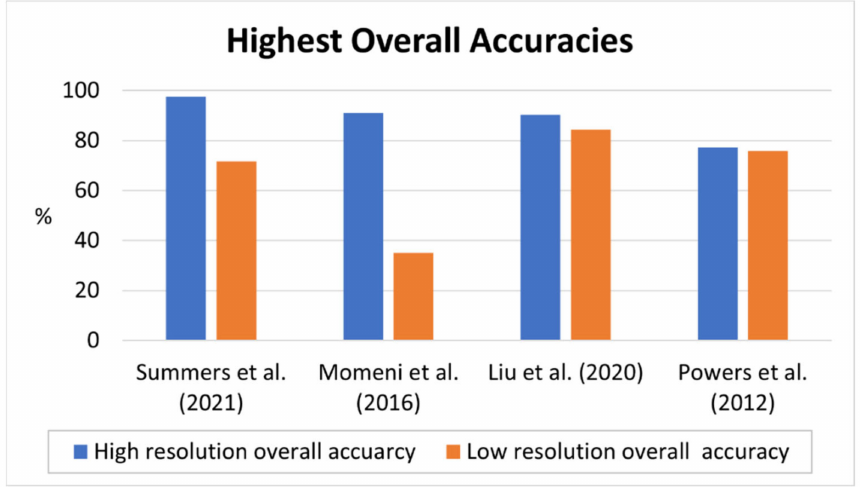
Figure 11. The highest overall accuracy for the highest-spatial-resolution data from this study and other studies within the literature employing multiple spatial resolutions within